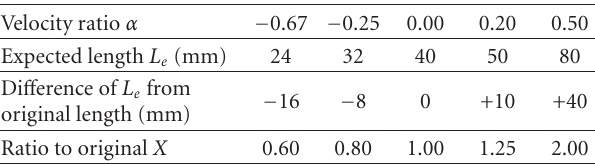
Table 1: Theoretically expected length L e (mm), di ff erence of L e from original length (40 mm), and its ratio X to original according to velocity ratio α .